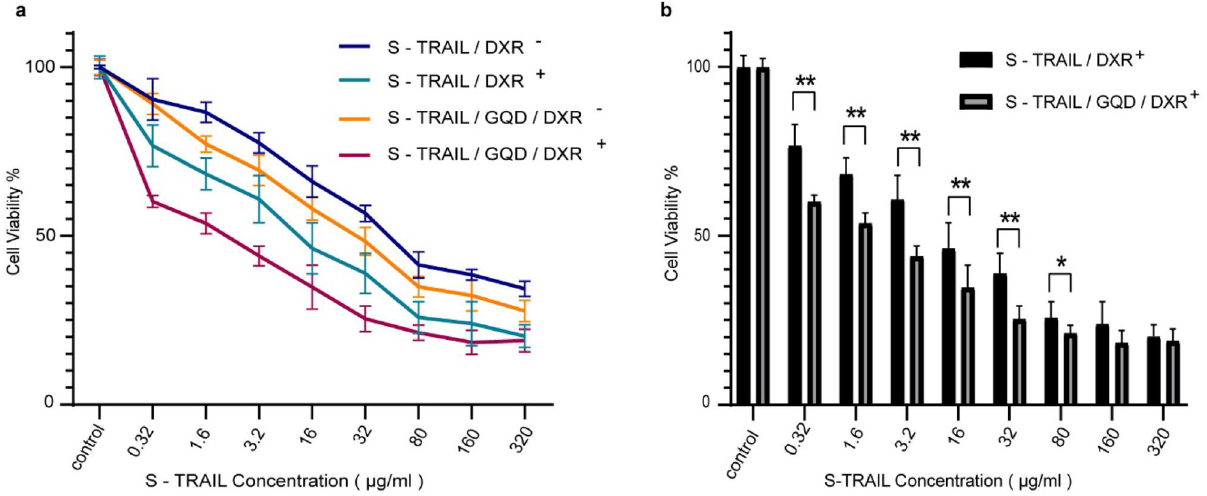
Figure 6. ( a ) In vitro cytotoxic activity of S-TRAIL and S-TRAIL/GQD with/without DXR pretreatment. ( b ) Cytotoxic effects of different concentrations of S-TRAIL and S-TRAIL/GQD following DXR pretreatment for 24 h. The statistical significance was determined using Student’s t-test. ∗ p < 0.05, ∗∗ p < 0.01, ∗∗∗ p <